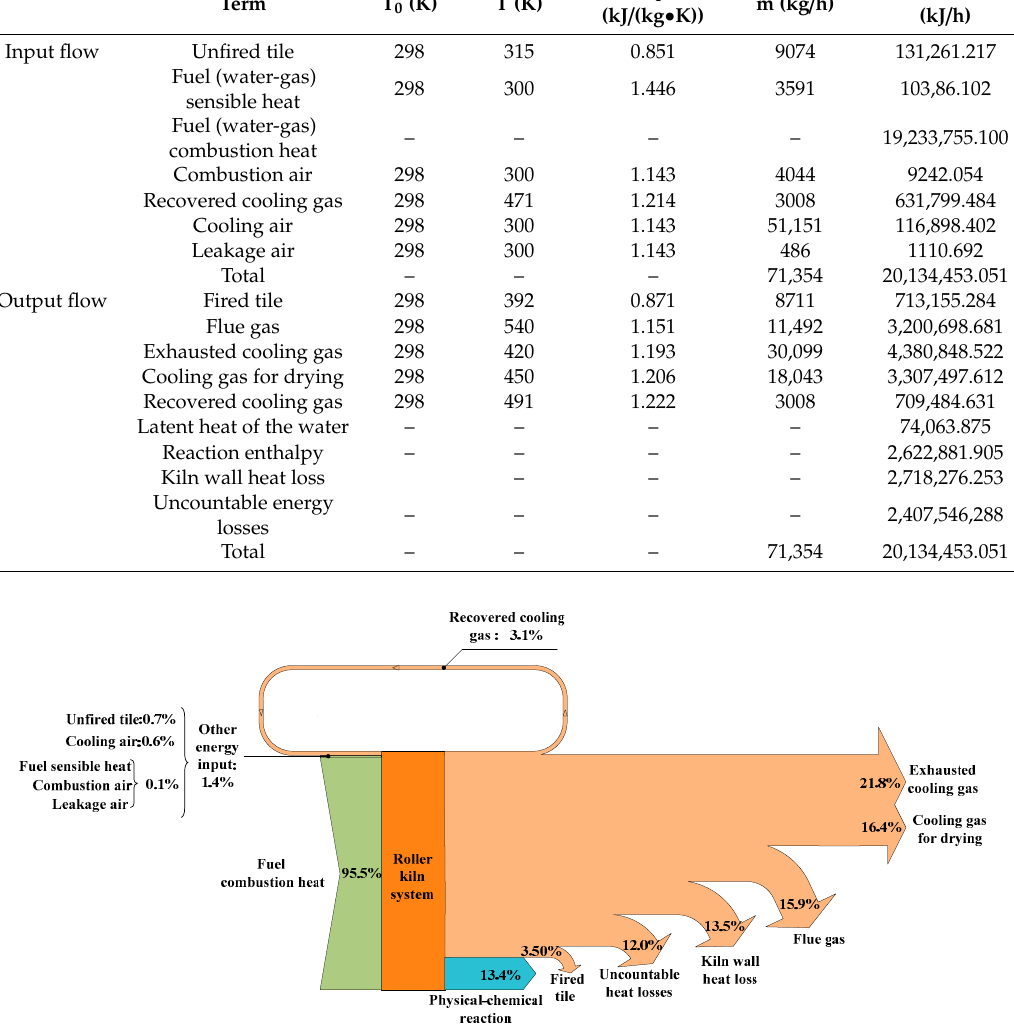
Figure 5. Sankey diagram for the roller kiln.